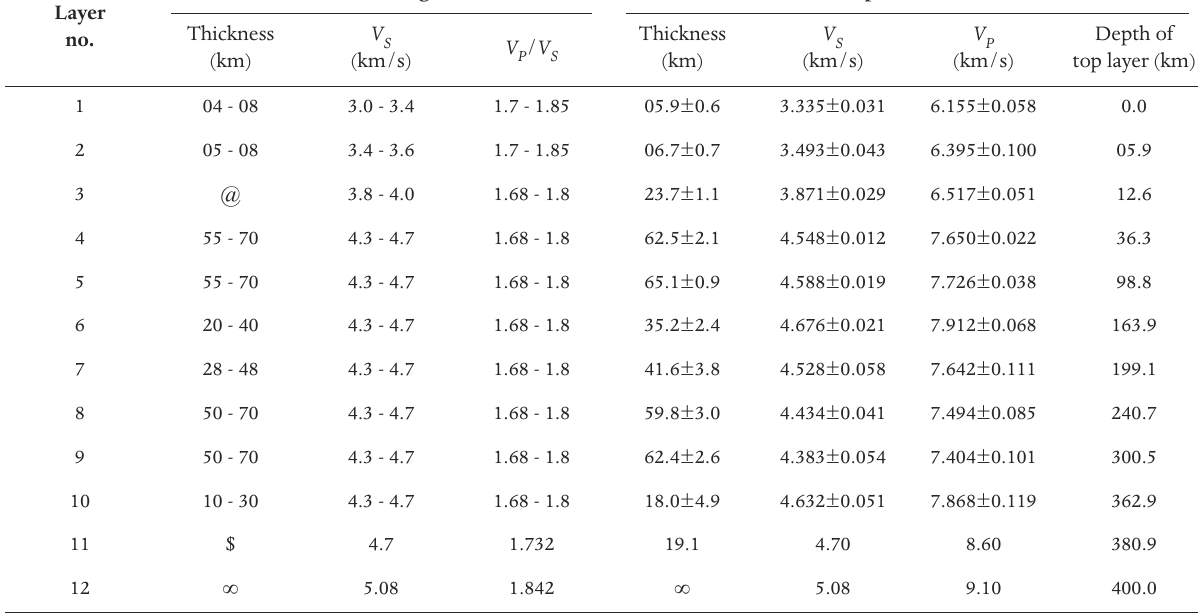
: P -wave velocity; V : S-wave velocity. Values after ‘±’ P S